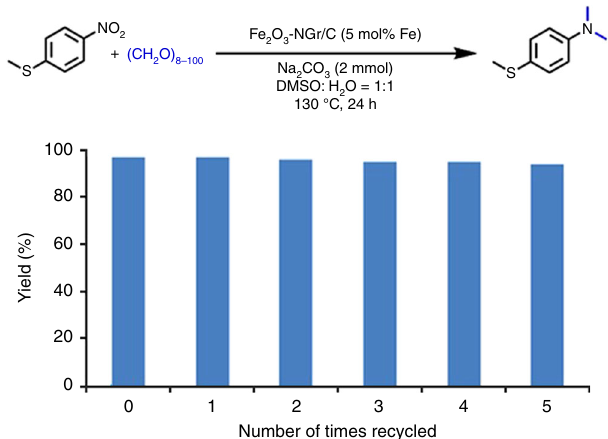
Fig. 8 Catalyst recycling. Recycling and reusability of Fe 2 O 3 /NGr@C- catalyst for the N, N -dimethylation of 4-nitrothioanisole. a Reaction conditions: 1 mmol 4-Nitrothioanisole, 100 mg catalyst (5 mol%), 600 mg paraformaldehyde, 2 mmol Na 2 CO 3 , 4 mL DMSO-water (1:1), 130 °C, 24 – 30 h, yields were determined by GC